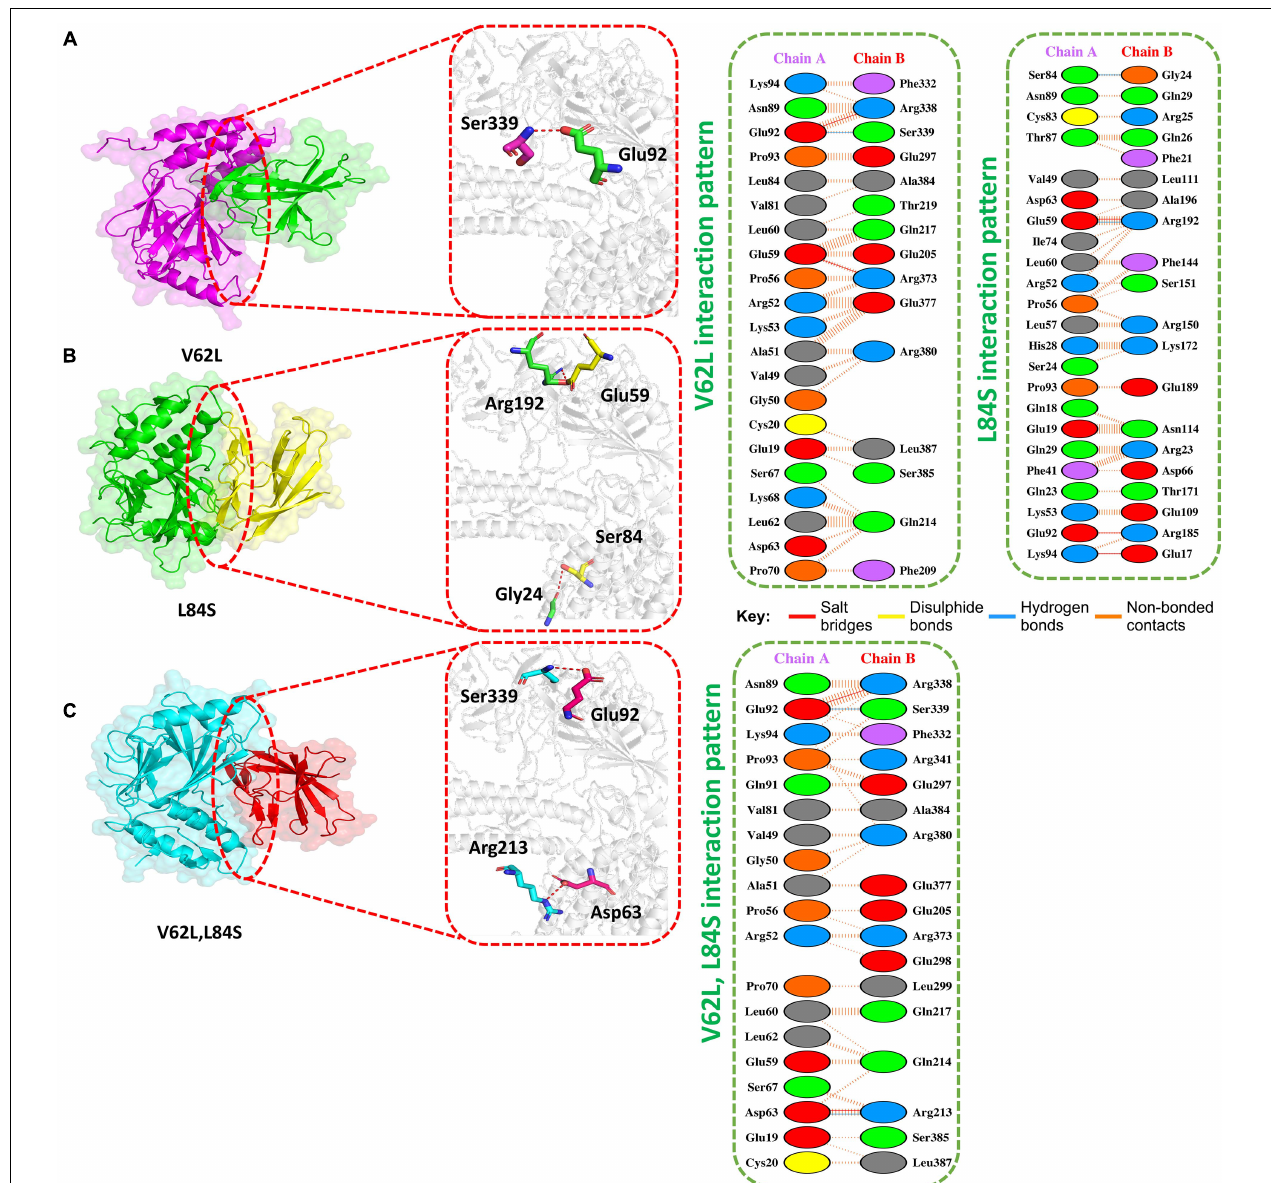
FIGURE 3 | Docking V62L, L84S, and V62L and L84S double-mutant complexes. (A) Key hydrogen bonding interactions of the V62L mutant with the IRF3 binding interface along with stick representation (left). 2D interactions representing salt bridges, hydrogen, and non-bonded interactions (right). (B) Key hydrogen bonding interactions of the L84S complex with the IRF3 binding interface along with stick representation of the ORF8 WT complex with IRF3 (left). 2D interaction representing salt bridges, hydrogen, and non-bonded interactions (right). (C) Key hydrogen bonding interactions of double mutants V62L and L84S with the IRF3 binding interface along with stick representation (left). 2D interactions representing salt bridges, hydrogen, and non-bonded interactions